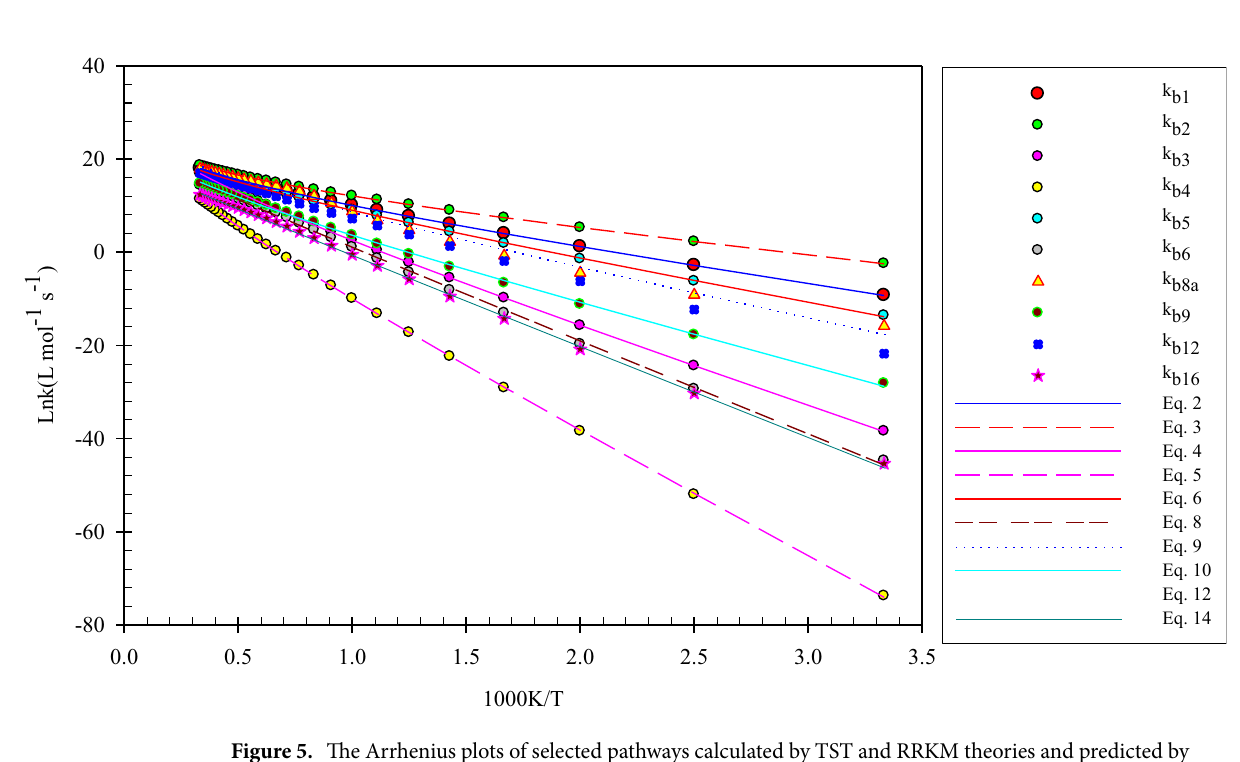
Figure 5. The Arrhenius plots of selected pathways calculated by TST and RRKM theories and predicted by equations